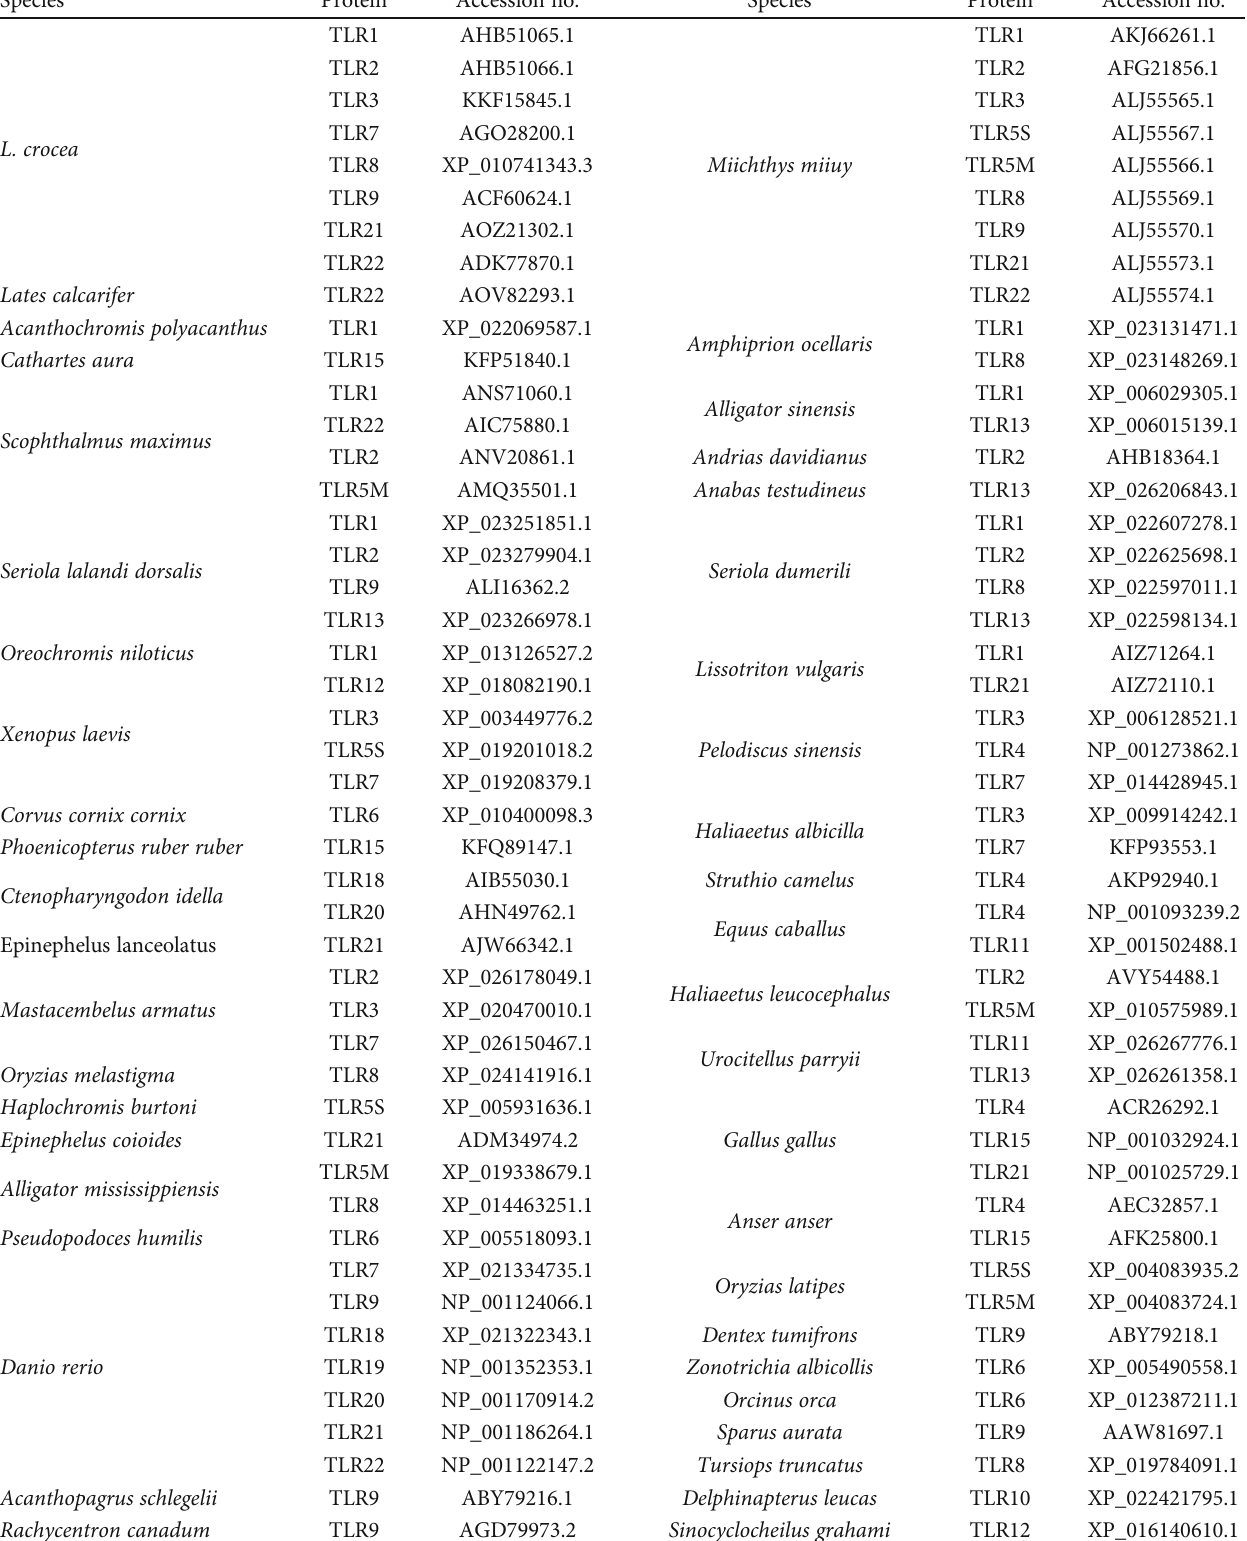
Table 1: The GenBank accession numbers of TLR amino acid